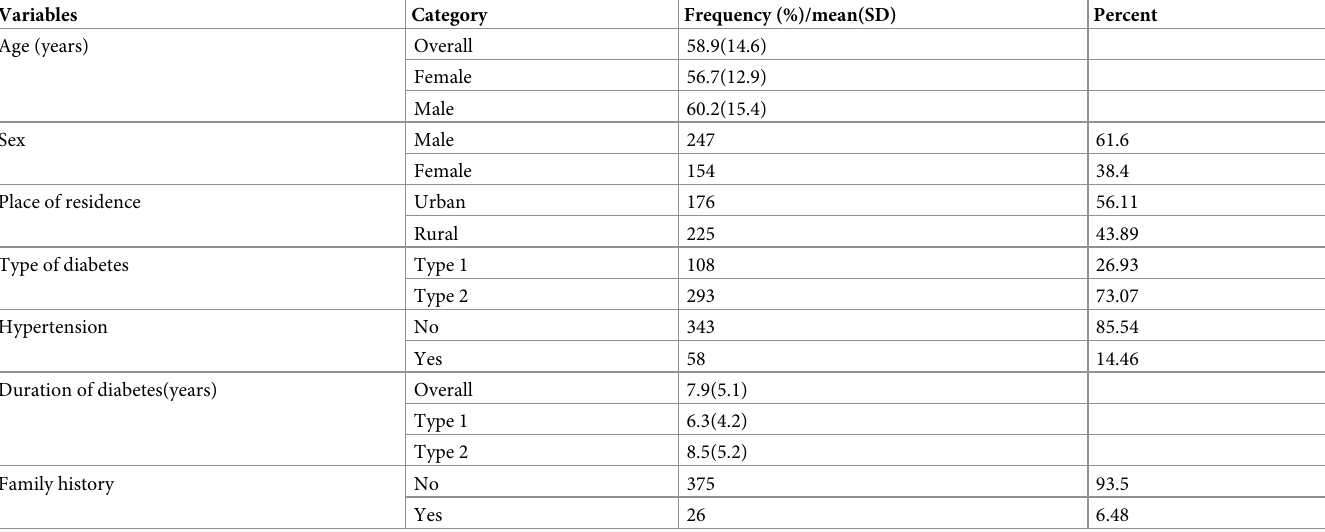
Table 1. Sociodemographic and clinical characteristics of study